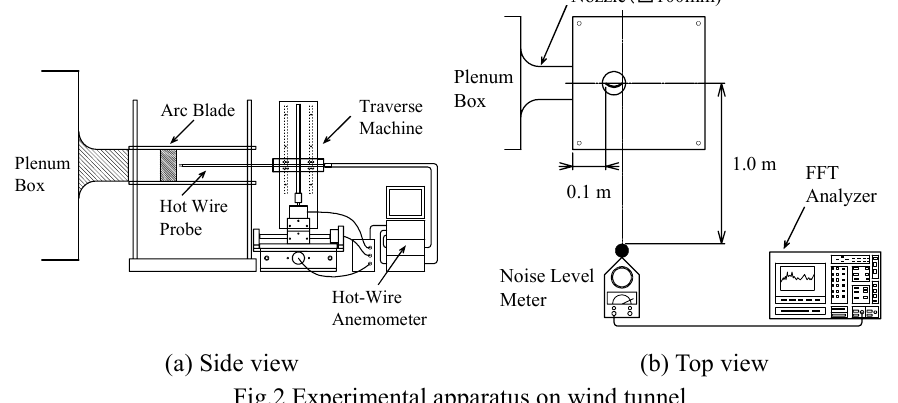
Fig.2 Experimental apparatus on wind tunnel